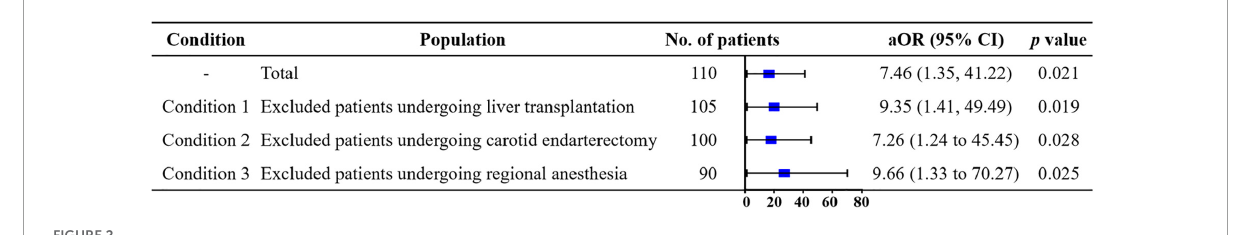
FIGURE2 Sensitivity analysis by adjusted for certain